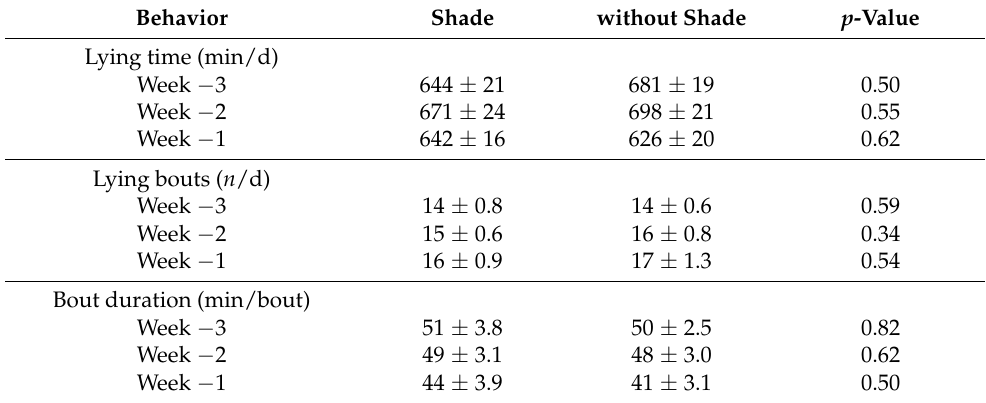
Table 2. Daily lying time, number of lying bouts, lying bouts duration, and rumination time (0000– 2359 h) were observed in cows with access to shade ( n = 12) and without shade ( n = 11) in different weeks prior to calving (LSM ± SE). p -values are presented by prepartum week, between treatments. Behavior Shade without Shade Lying time